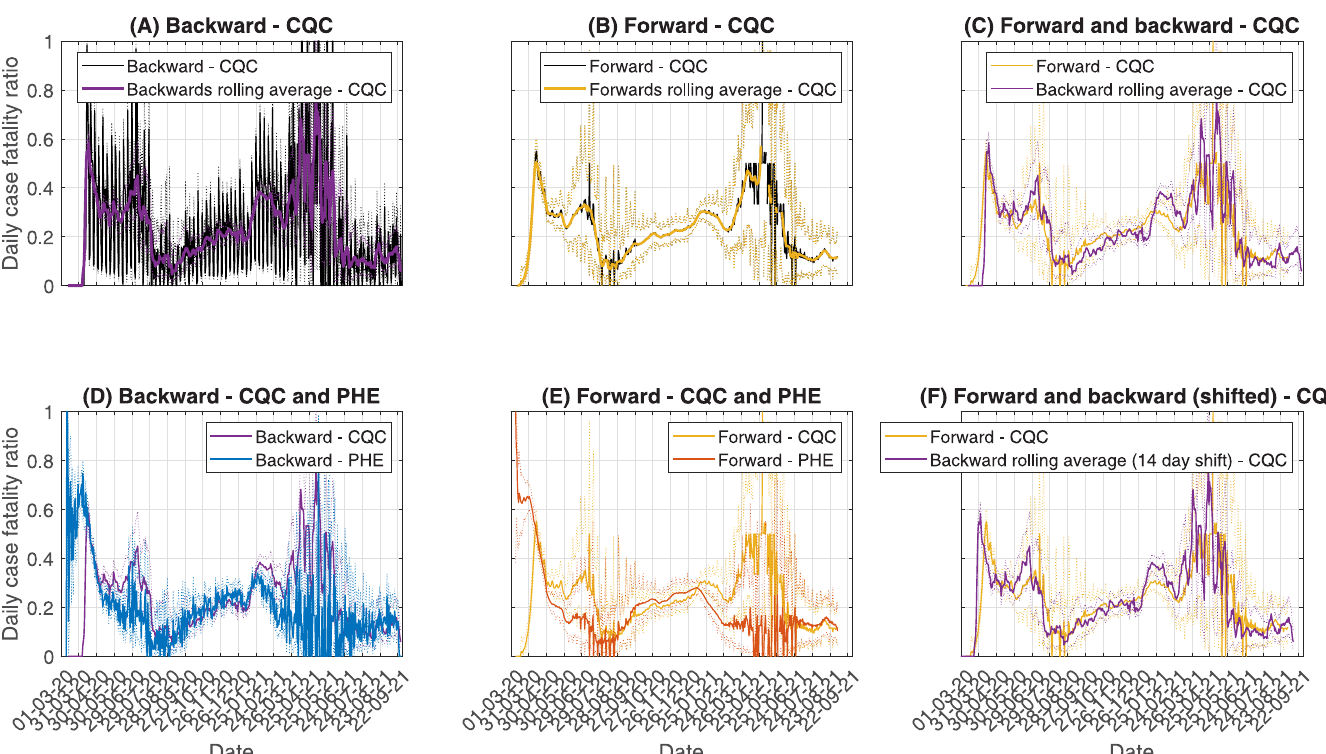
Fig 5. Comparing estimates derived from the CQC data to the PHE data. Since the CQC data uses date of report, we have strong weekend effects in the backward method, so also look at the 7-day rolling average (A). The forward method does not exhibit the weekend effects, since this method smooths through nearby CFR estimates, so the 7-day rolling average is not necessary here (B). When comparing forward and backward (C) and (F), we use a 14-day time shift, since this is the expected delay used from testing positive to reporting death. In (D) and (E) we plot the PHE estimates for comparison.